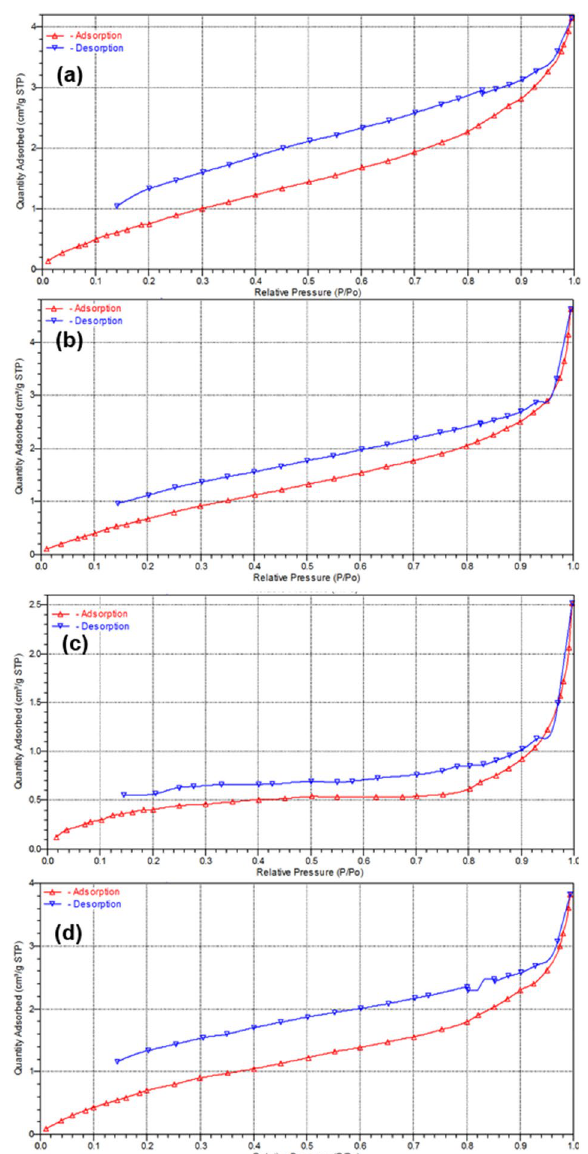
Figure 6. Linear isothermic plots of ( a ) CHT; ( b ) CHT-mPEG; ( c ) CHT-mPEG-CHO; and ( d ) CHT-mPEG- COOH.